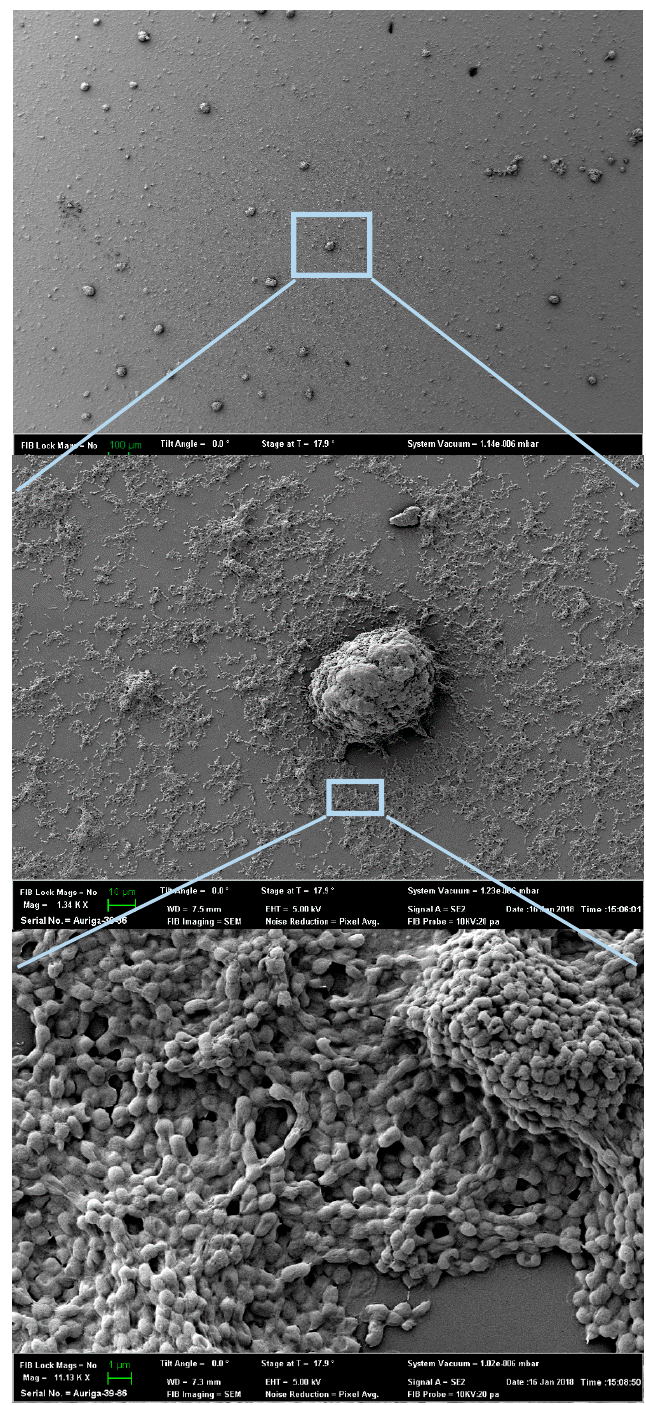
Figure 4. Scanning Electron Microscopy (SEM) image of P. putida TVA8 on the (3-aminopropyl) (APTES) modified OFE after the second day of adsorption.